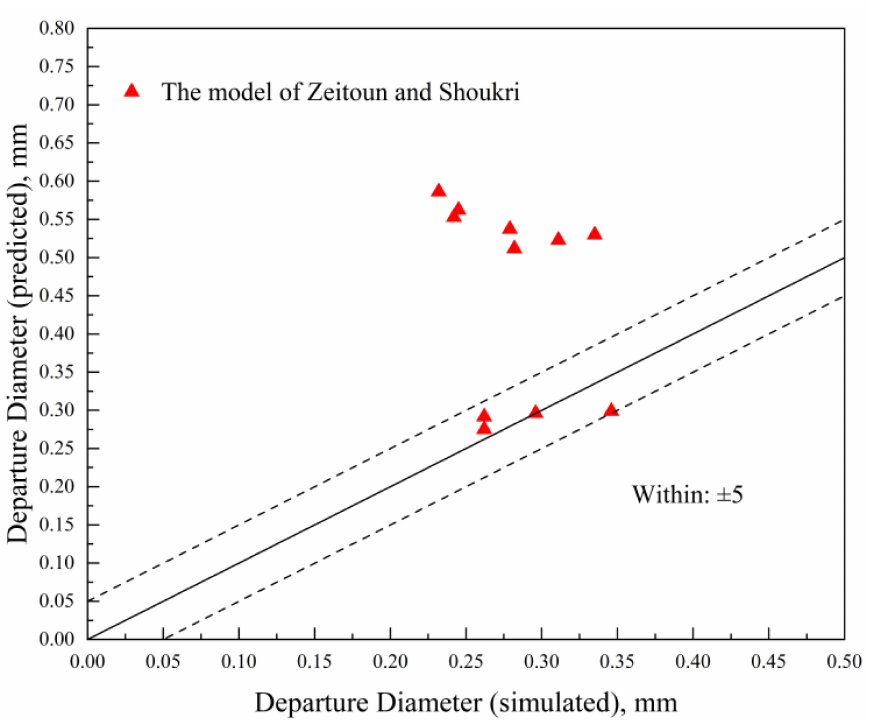
Figure 16. The comparison of departure diameter of the simulation with the predicted departure diameter obtained by the Zeitoun and Shoukri